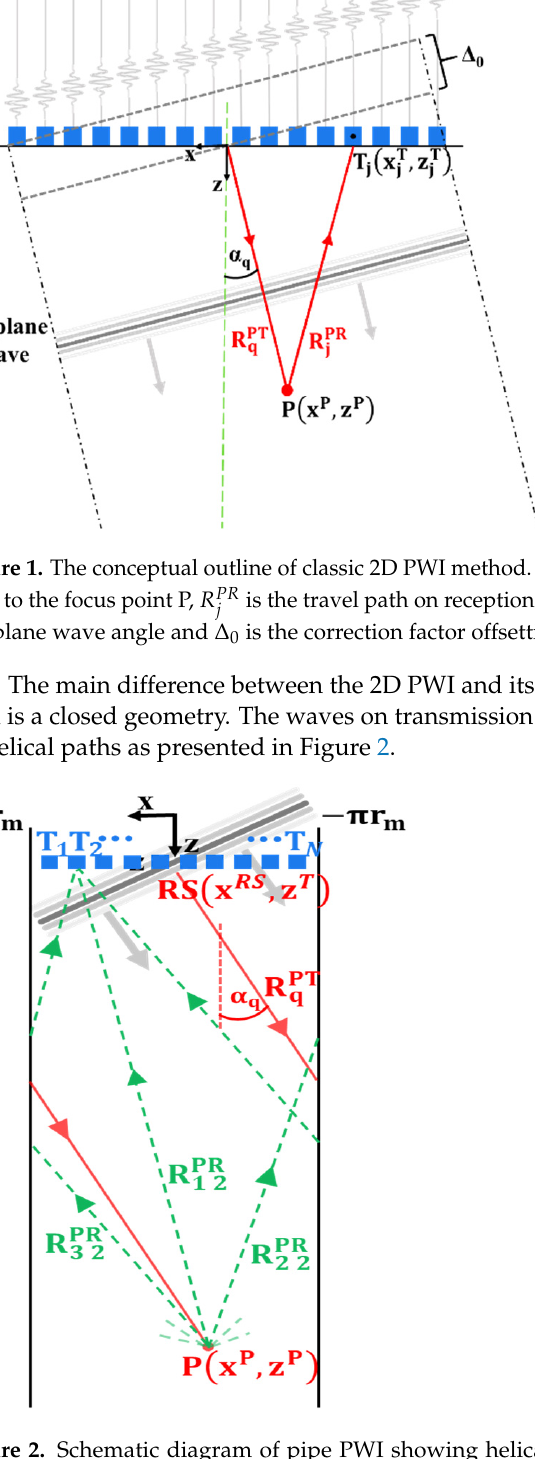
(cid:3017)(cid:3019) is is the (cid:3040)(cid:3037) mj